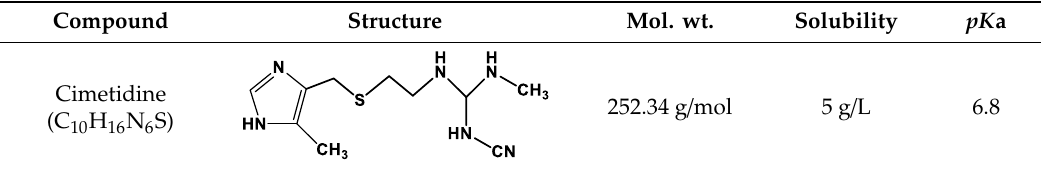
Table 1. The physicochemical characteristics of cimetidine.